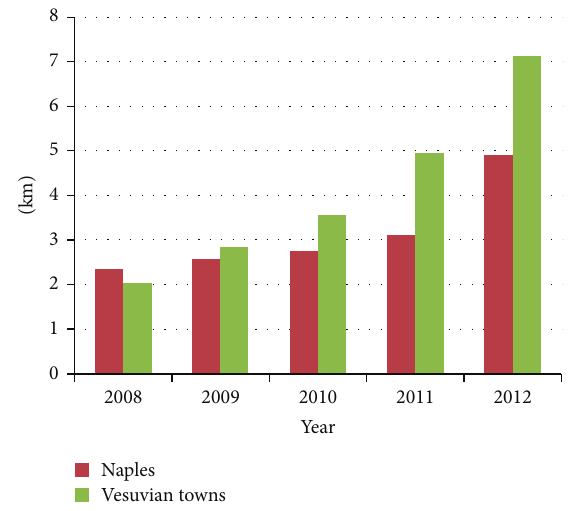
Figure 10: Nasal polyposis disease—histogram showing the varia- tion of the radius of the two hotspots over